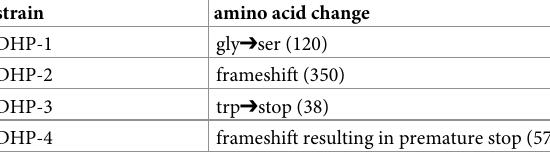
Δ opuC Δ opuD Δ proP Δ putP via ϕ 11 transduction. The resulting strain JE2 Δ opuC Δ opuD Δ proP Δ putP Δ B7H15_03660 (hereafter referred to as the penta mutant) was resistant to DHP, similar to isolates DHP 1–4 (Figs 1A and S1A). Additionally, the penta mutant had reduced growth yield (reaching a lower final OD ) in CDM, phenocopying the growth yield observed 600 when JE2 is grown in CDM lacking proline (CDM-P) (Fig 1B). These data reveal that exoge- nous proline is not utilized as a carbon source in the penta mutant even if proline is added to the medium. To confirm that the growth observed in the penta mutant was dependent on proline biosynthesis, we transduced a proC mutation into the penta mutant. proC encodes pyr- roline-5-carboxylate reductase and is the terminal enzyme responsible for proline synthesis (S1C Fig). Therefore, JE2 Δ proC is unable to grow in CDM-P due to a lack of exogenous pro- line and an inability to synthesize proline using arginine as a substrate [5]. The penta Δ proC strain was unable to grow in CDM or CDM-P (Fig 1C), indicating that the penta mutant, in contrast to JE2 Δ opuC Δ opuD Δ proP Δ putP , did not have a functional proline transporter. Overall, these data show that S . aureus may encode up to five proline transporters, including B7H15_03660.